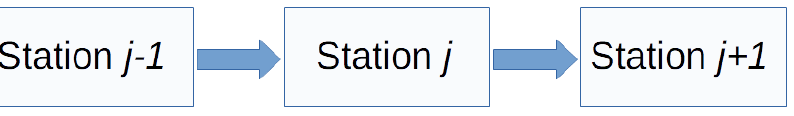
Figure 1. Serial production